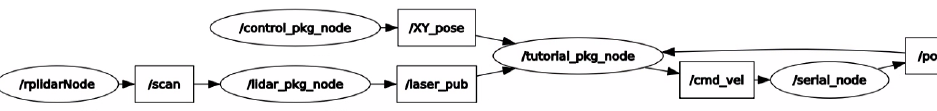
Figure 8. Graph of the data